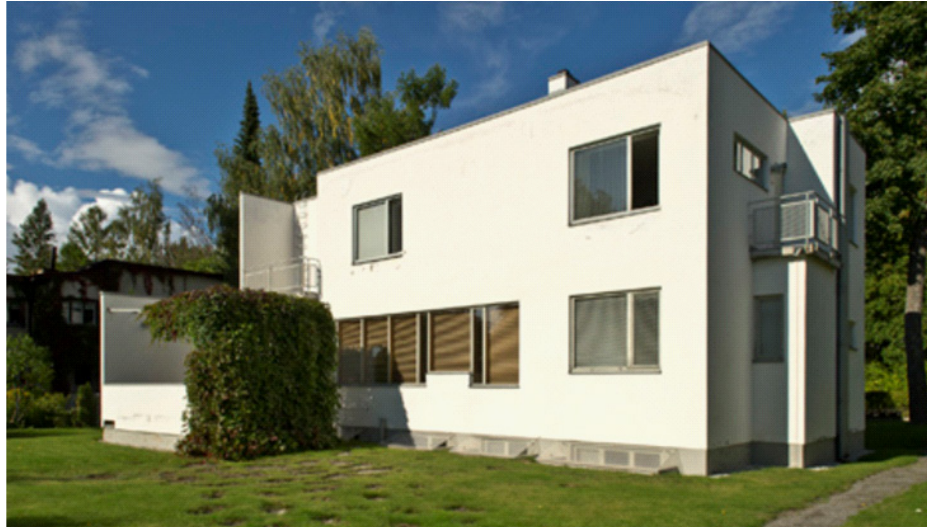
Figure 10: J.G. Granö Centre Tartu (photograph courtesy University of